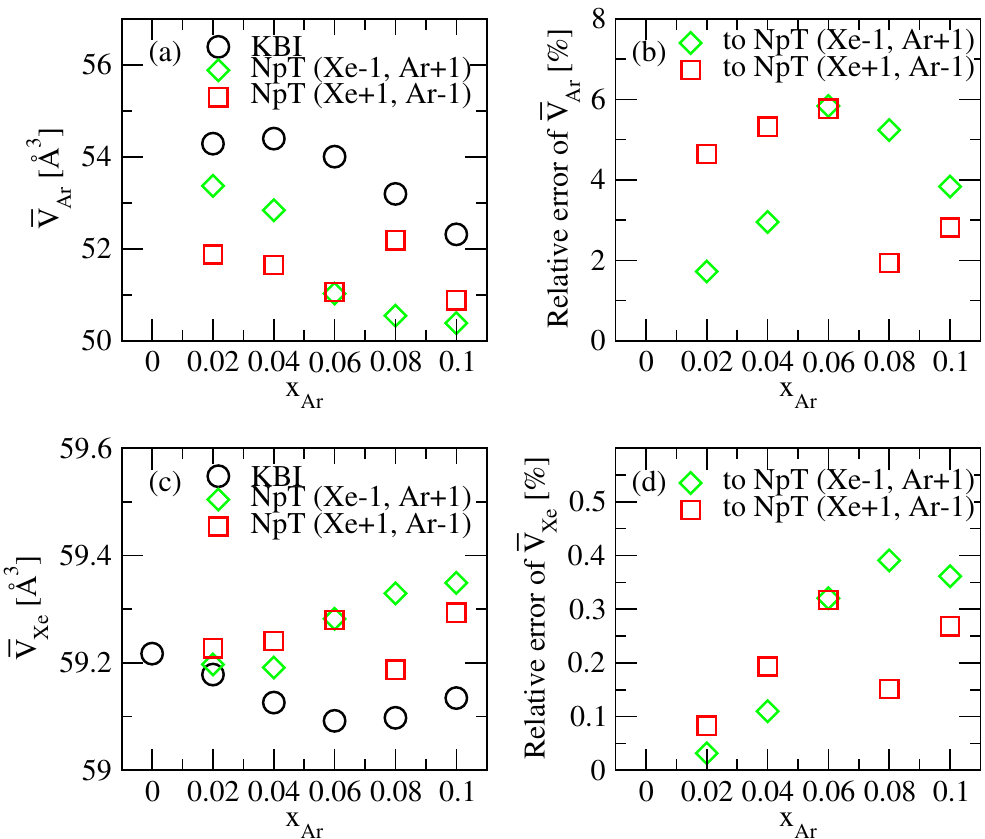
Figure 5. Partial molar volumes, ( a ) ¯ V Ar and ( c ) ¯ V Xe , at T = 85K, from KBI (black), and NpT simulations with particle numbers ( N Xe − 1, N Ar +1) (green) or ( N Xe +1, N Ar − 1) (red). ( b , d ) show the relative errors of ¯ V Ar and ¯ V Xe from the KBI, with respect to the values obtained from NpT. The difference between the partial molar volumes obtained with the KBI and NpT is at a maximum of 6% for Ar and 0.4% for Xe, and so, the KBI error is comparable to the NpT error; see Figure 5b,d. The fact that the error of the minority type (Ar) is much larger than that of the majority type (Xe) is expected because of poorer statistics for the minority